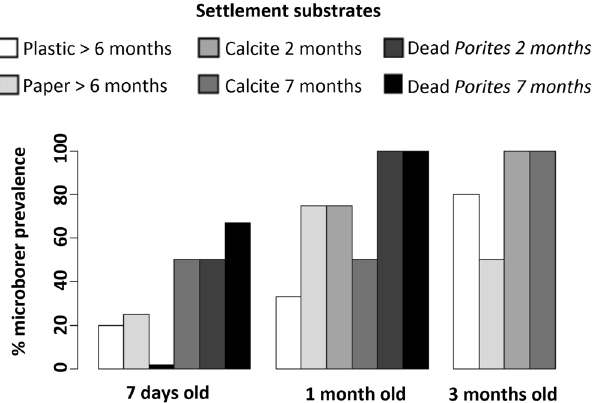
Figure 2. Substratum-dependent microborer colonization of coral recruits. Euendolithic filaments were detected by photonic and/or scanning electron microscopy in skeletons of P. damicornis (2 to 9 replicates per life stage and substrate type). One month old recruits developed on clean glass had 25% microborer prevalence. Data for 3 months old recruits on dead Porites are missing because full colonization was already reached on these substrates in 1 month old recruits (100% prevalence) and -given the limited availability of larval material- focus was given to the colonization